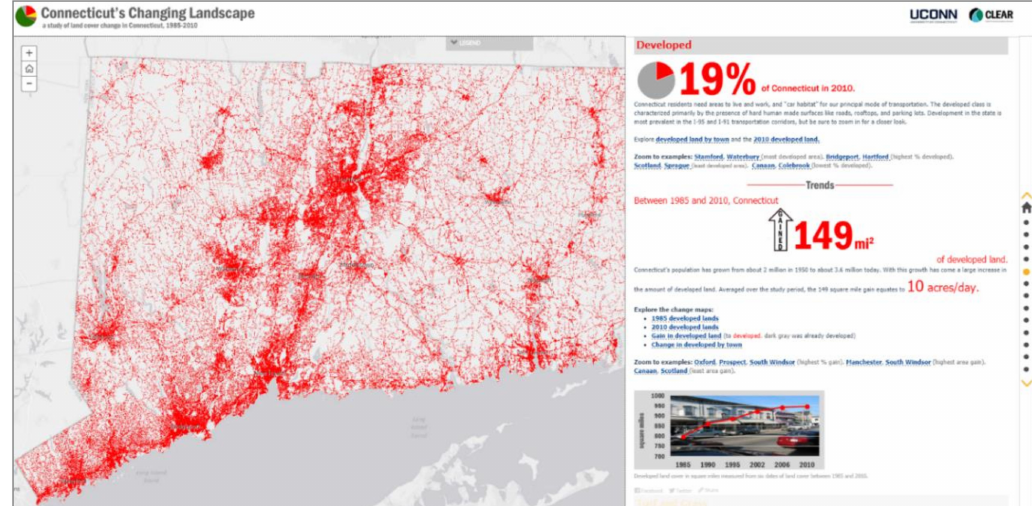
Figure 10. The developed class “page” of the CCL Story Map, combining the interactive map on the left with text, graphics, and links on the right. Users can pan, zoom, and click on the map to view additional